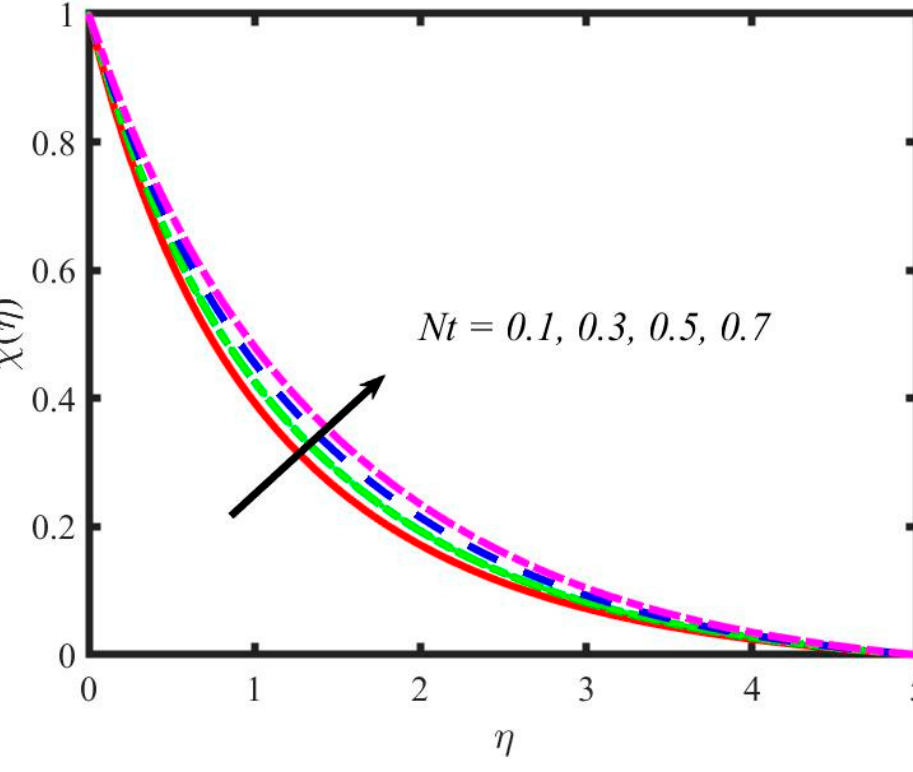
Figure 24. Variations in microorganism profile for thermophoresis parameter.